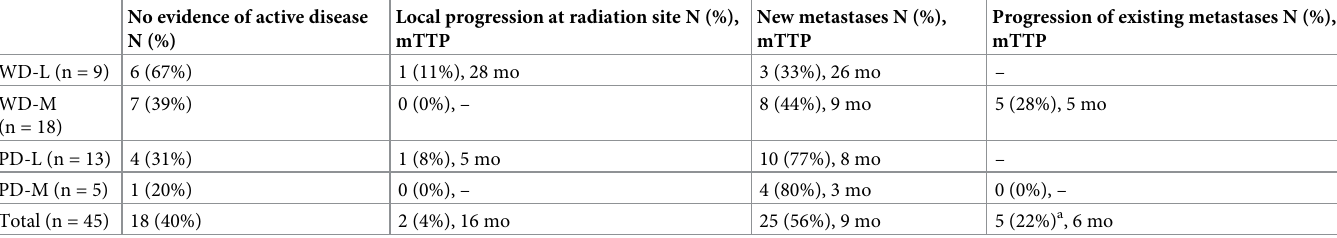
Table 2. Median time to progression by differentiation and stage after high-dose radiation (n =